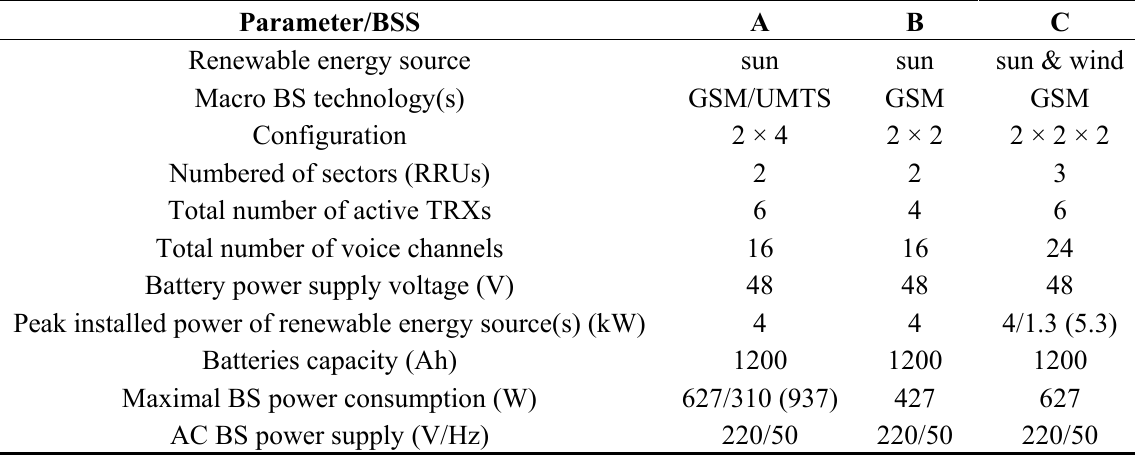
Table 1. Technical characteristics of analyzed